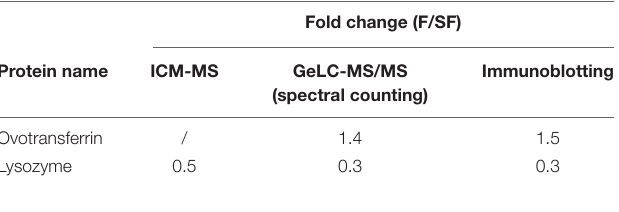
TABLE 2 | Comparison of the protein abundance fold change between fertile (F) and subfertile (SF) sperm obtained by ICM-MS, GeLC-MS/MS, and western blotting for ovotransferrin and